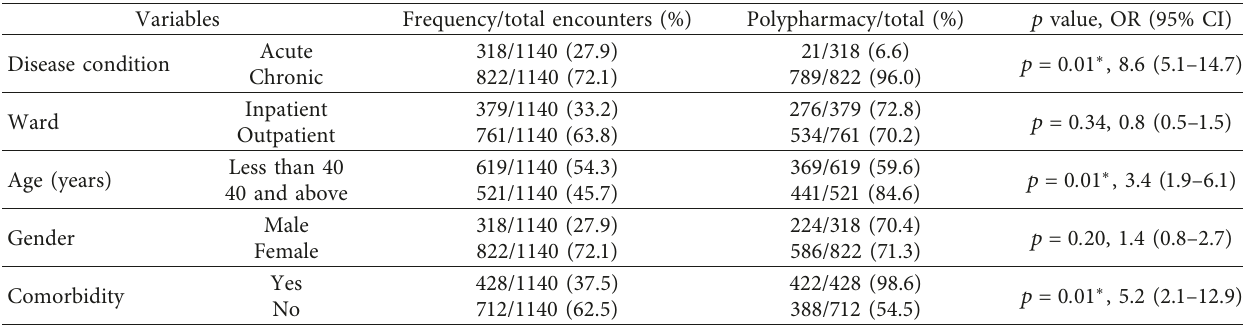
Table 1: Association between overall polypharmacy ( N � 810) and predictors at Edna Adan University Hospital from August 28, 2019, and